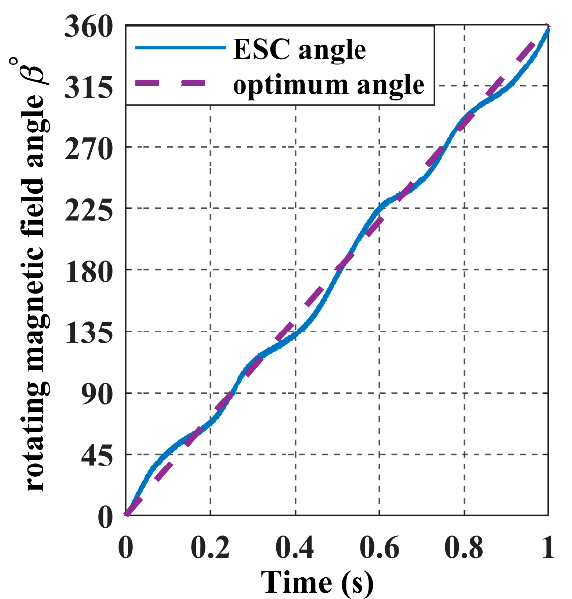
Figure 23. The rotating magnetic field angle β in the closed-loop when the receiver moves according to the 8-shaped trajectory 𝝘 .